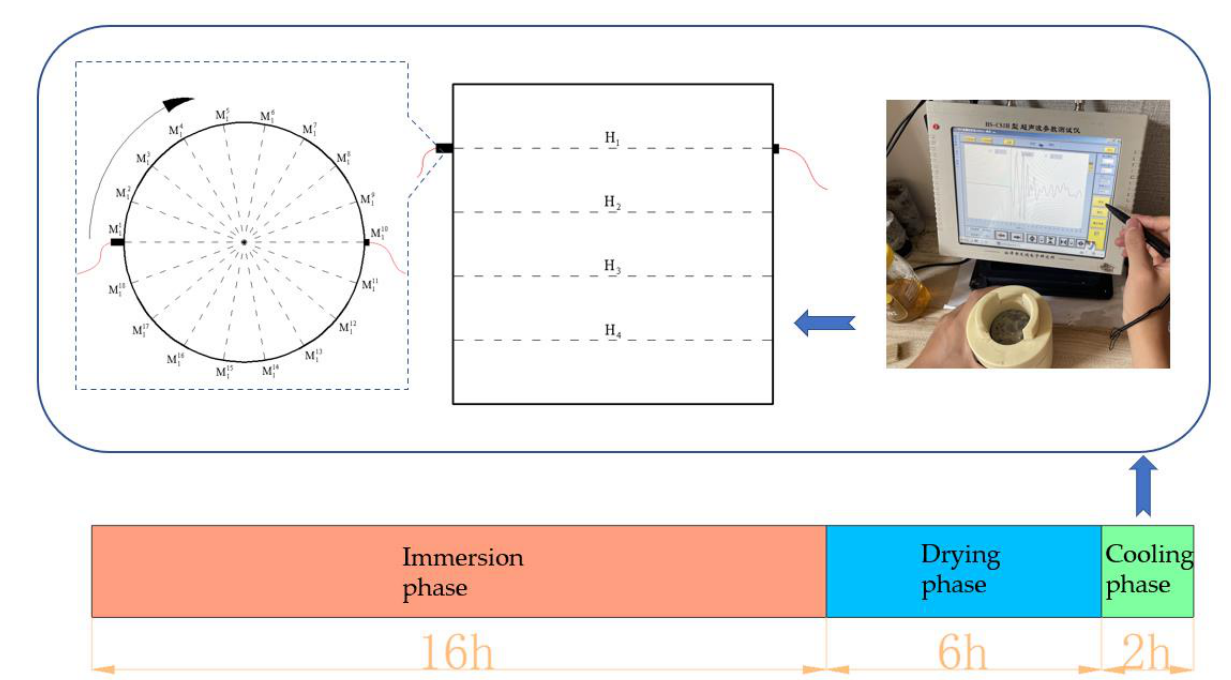
Figure 3. Ultrasonic velocity test scheme.